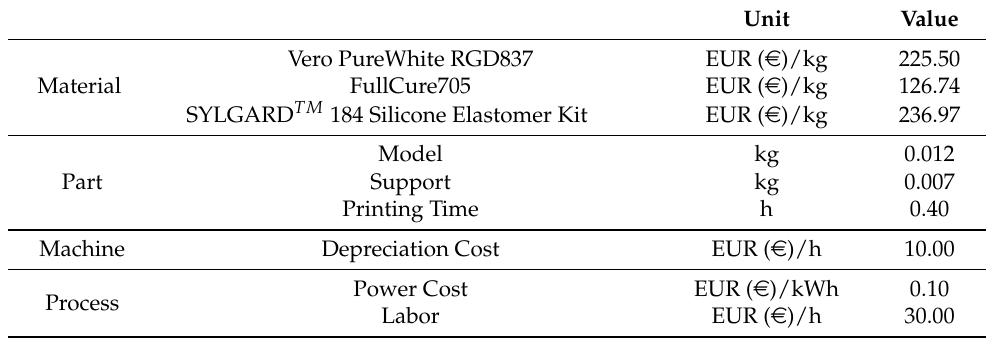
Table 2. Cost model input parameters considered for the PDMS- µ SPT